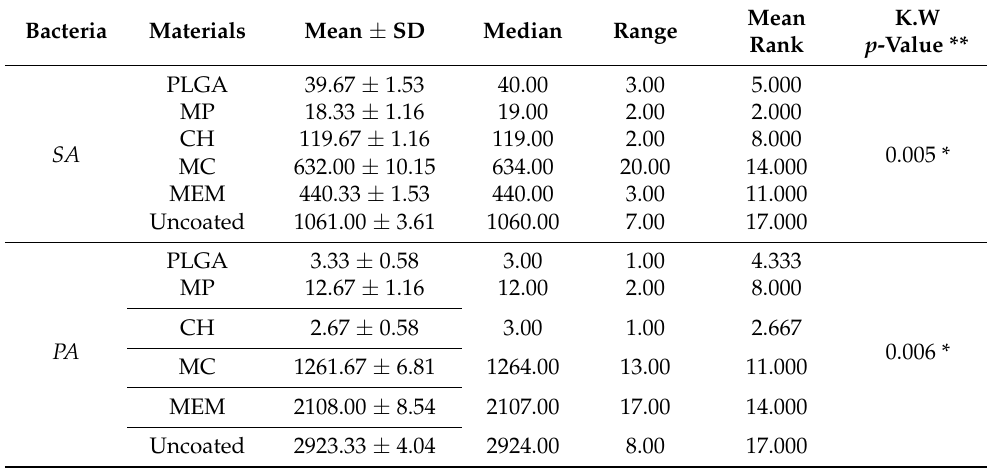
Table 1. Bacterial count on the different materials. Bacteria